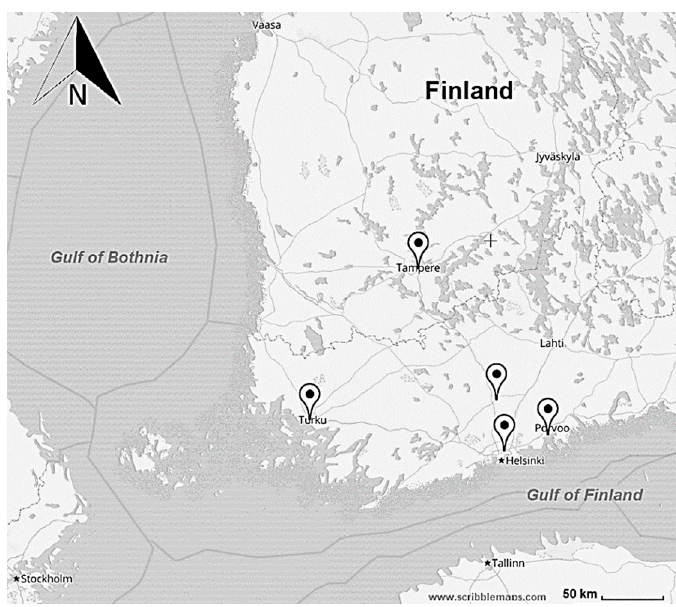
Figure 1. Sampling locations. 1–5–full-scale wastewater treatment plants (WWTPs), 6–9 pilot